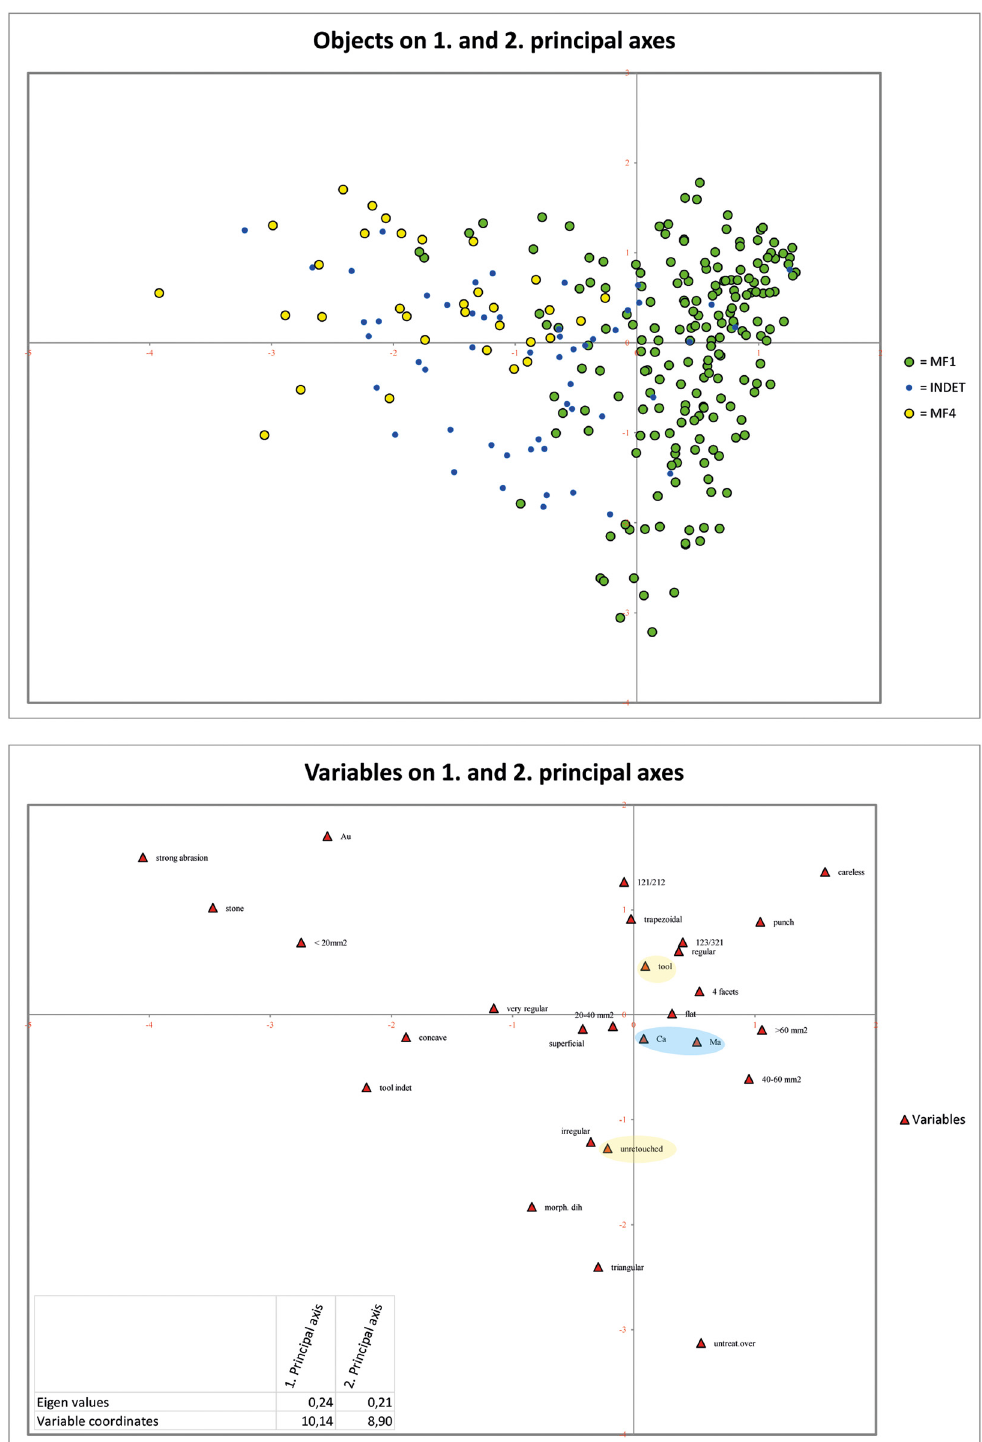
Figure 2: Correspondence analysis made on LPC data from Vaux - et - Borset settlement to verify, whether the structure of empirically de fi ned MF1 and MF4 technological groups is relevant. The di ff erent variables selected are related to the raw materials ( Campanian - Ca, Maastrichtian - Ma, Ghlin - Gh, Bartonian - Ba, Others - Au ) , the butts ( fl at, concave, morphologically dihedral, dihedral ) , the overhang preparation ( untreated, super fi cial abrasion, strong abrasion, careless preparation ) , the tool used to prepare overhang ( stone tool, punch, indeterminate ) , the section of the blades ( triangular, trapezoidal, 4 facets ) , the operative codes ( 123/321 versus 212 ′ /121 ′ ) , the regularity of the blades ( very regular, regular, irregular ) , the dimensions of the butt ( inferior 20 mm 2 ; between 20 and 40 mm 2 ; between 40 and 60 mm 2 ; more than 60 mm 2 ) and if the blades are tools or not ( unretouched )